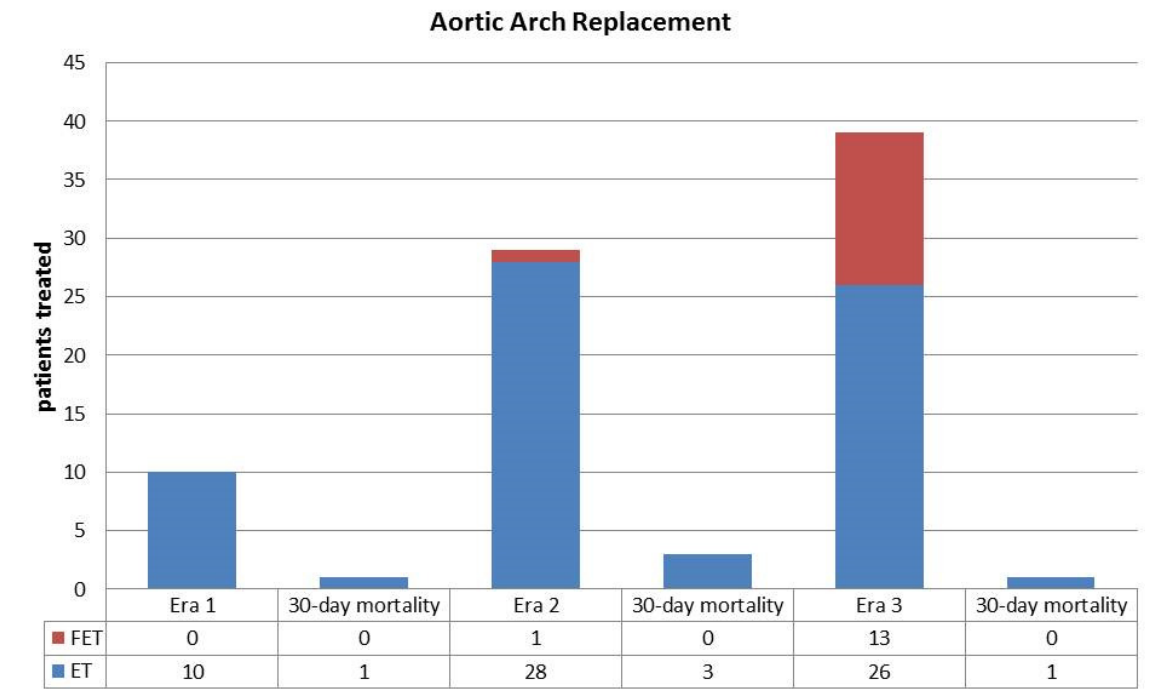
Figure 3. Comparison of number of classic elephant trunk (ET) and frozen (FET) procedures and related operative mortality in the three different surgical eras.